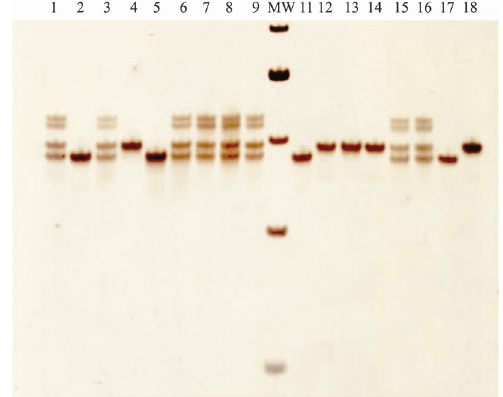
Figure 1 - Detection of ∆ F508 mutation by PCR in 8% polyacrylamide gels. Lanes 1, 3, 6, 7, 8, 9 and 15 are heterozygous patients (one 98 bp fragment and one 95 bp one). Lanes 2, 5 and 11 are homozygous patients (two 95 bp fragments), and lanes 4, 12, 13 and 14 are non- carrier patients (two 98 bp fragments). Lane 16 presents the heterozygous control, lane 17 the homozygous control and lane 18 the non-carrier control. Molecular weight (MW) is the 25 bp molecular weight marker (Invitrogen, USA). The 5 MW fragments are (from top to bottom): 150 bp, 125 bp, 100 bp, 75 bp and 50